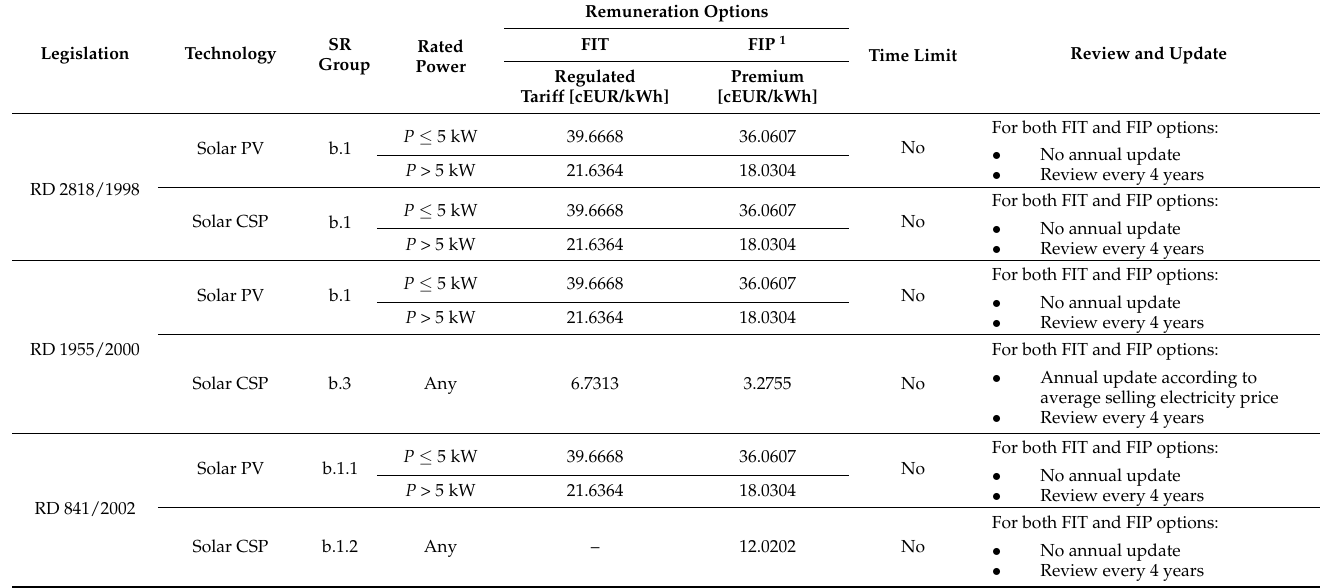
Table 2. Major characteristics of the different economic regimes in force for solar power systems in Spain in the period 1998–2004. Source: self-elaboration based on